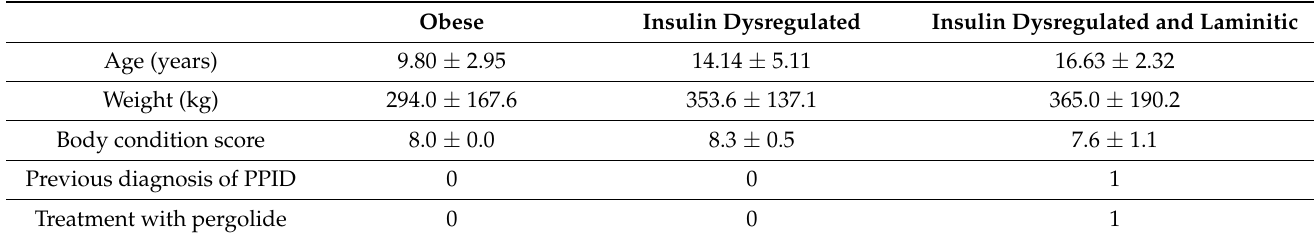
Table 1. Demographic data of study participants (mean +/ − standard deviation or absolute numbers of horses). Obese Insulin Dysregulated Insulin Dysregulated and